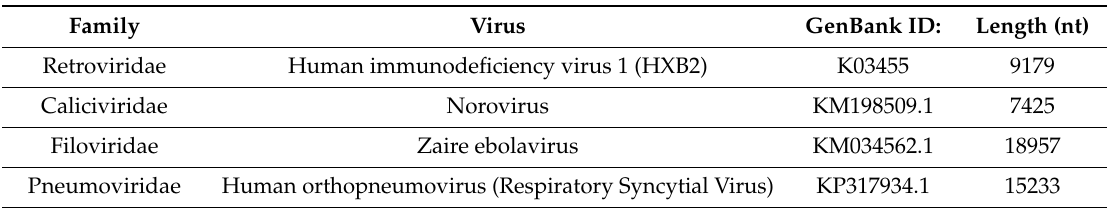
Table 4. Reference genomes used during classification and reference-based